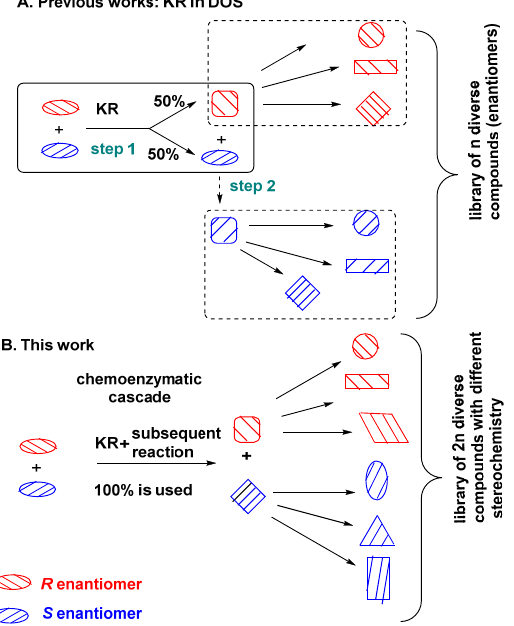
Figure 1. The application of KR in DOS. ( A ) Previous works: KR in DOS; ( B ) This work. tion reaction with a subsequent ring-closing metathesis as the second reaction (Scheme 1).